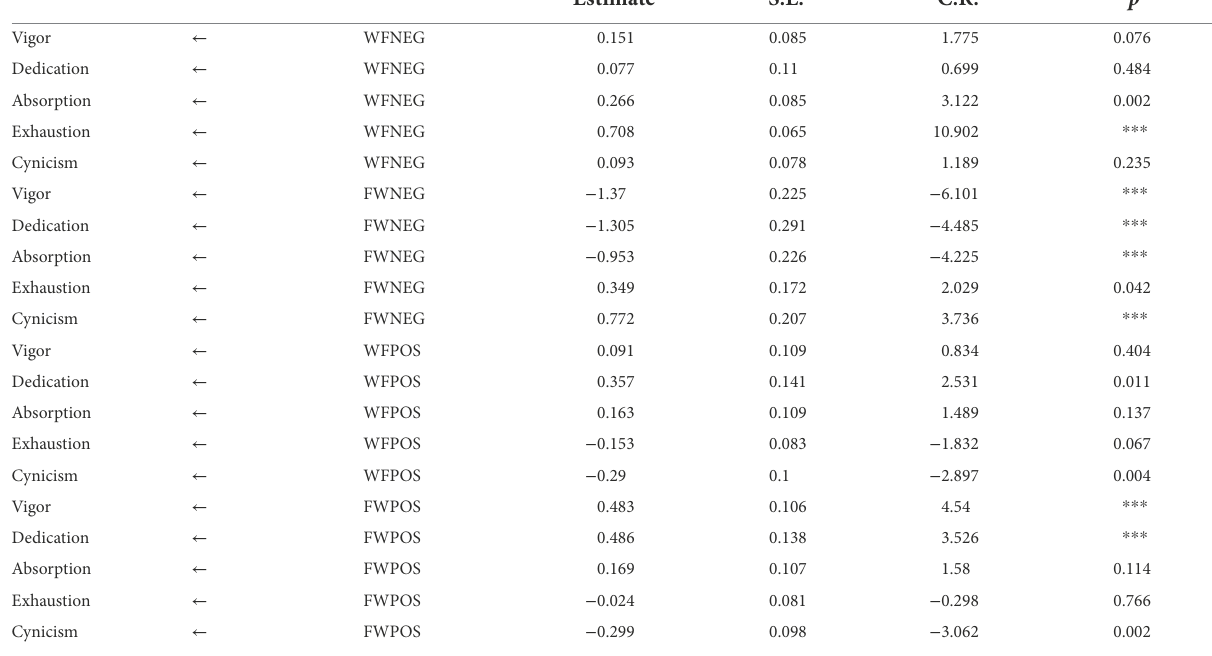
TABLE 5 Regression weights.